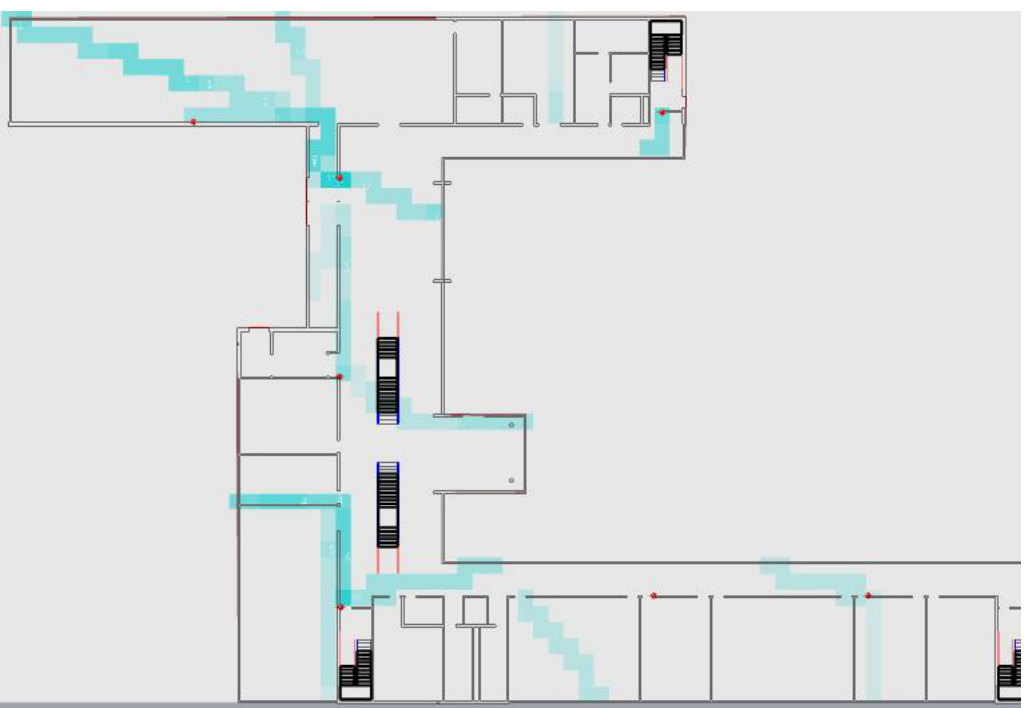
Figure 8. Heatmap of the con-fire safety planning Simulation